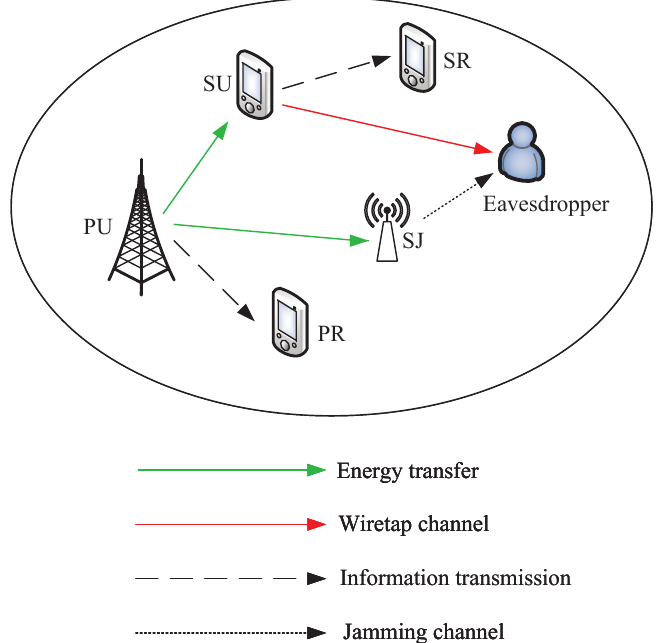
Figure 1. System model. The underlay CR networks with one PU, where SU uses the harvested energy to transmit confidential information to SR and SJ simultaneously employs the captured energy to confuse the eavesdropper.